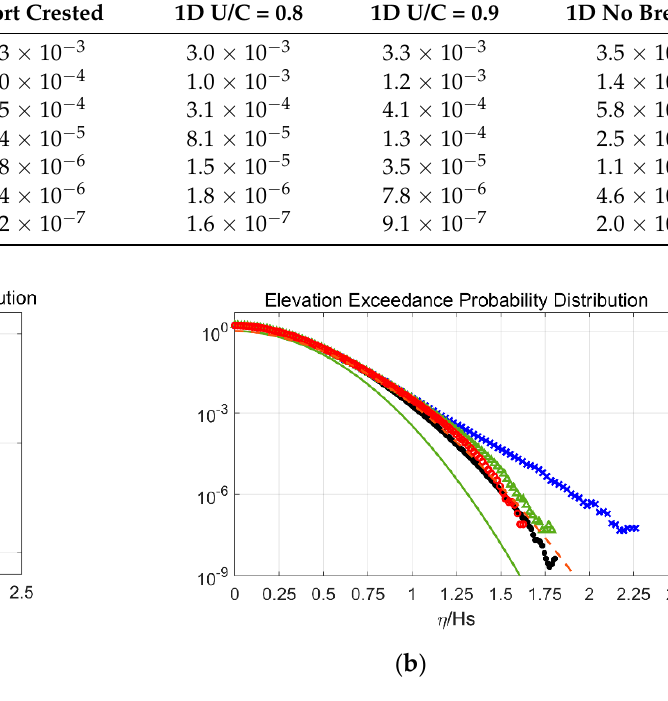
Figure 22. Elevation exceedance plots for the short-crested Draupner sea (black), and the 1D long-crested waves without breaking (blue, highest), with breaking for U/C = 0.9 (green, middle) and with breaking U/C = 0.8 (red). ( a ) for the cumulative probability distribution, and ( b ) for the probability distribution. The lines in the elevation exceedance probability distribution plot are the crest exceedance probability of the Rayleigh distribution (solid green) and Forristall 3D (dash-red). Table 4. Quantitative data of Elevation Exceedance for the four waves cases. Note that, comparing < 1.5 , the probability of the 1D long- the short-crested waves with 1D long-crested waves, for (cid:3086) (cid:3009) (cid:3294) = 1.6 the probability of crested waves with U/C = 0.8 is, on average, a factor two higher, but for (cid:3086) (cid:3009) (cid:3294) short-crested waves becomes much higher.